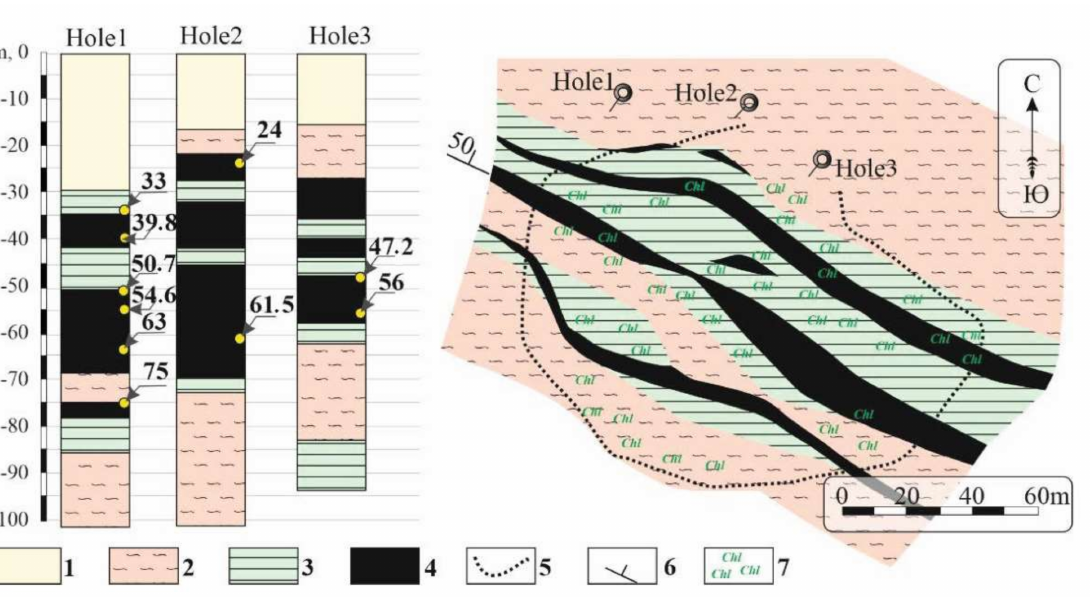
Figure 2. Geological sketch map of the Leksa deposit (compiled using the data of Kuleshevich (1992) and Kuleshevich et al. (2005) [40,41] with some modifications and additions). 1—Quaternary sediments, 2—quartz–carbonate–albite–sericite schists, 3—carbon-bearing schists, 4—sulfide ores, 5—silicification zone, with chloritoid blastesis (Chl), with fuchsite, 6—attitude, 7—metasomatic alteration zones (chloriti- zation). Yellow dots on drillhole logs indicate sampling locations and depth below the